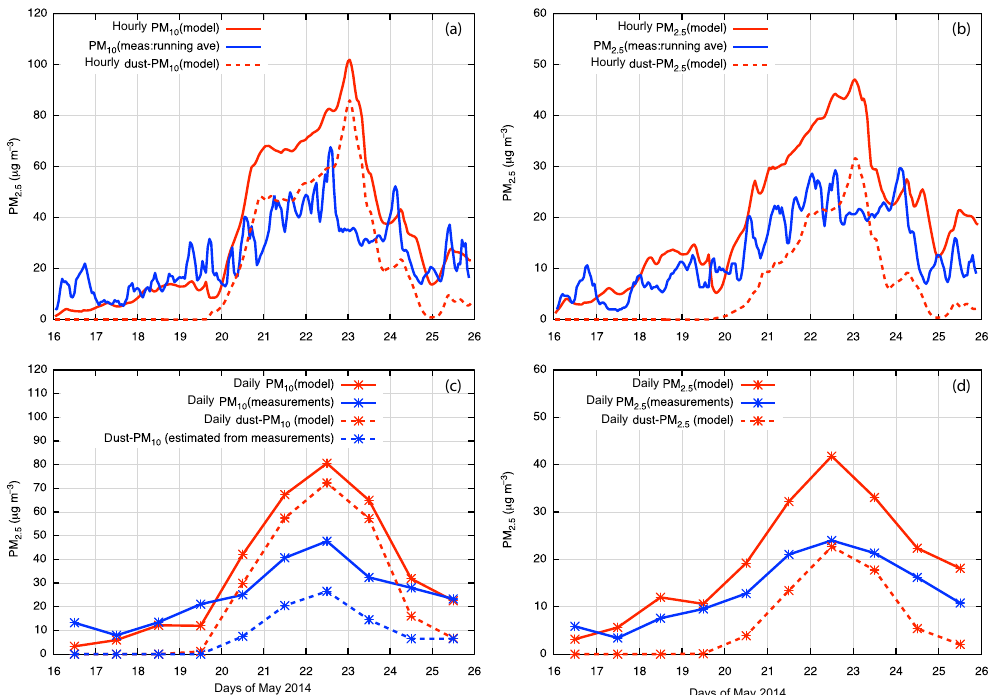
Figure 9. Temporal evolution of surface level PM 2 . 5 and PM 10 values and relevant desert dust contribution at Rome (Castel di Guido site) during the investigated period: (a) hourly resolved evolution of S01 modeled PM 10 (red continuous line), S01 modeled desert dust PM 10 (red dashed line), and PM 10 measurements (3h running average, blue continuous line); (b) as in (a) but for PM 2 . 5 ; (c) as in (a) but for daily-averaged data – in addition, daily desert dust PM 10 values obtained from measurements have been reported (dashed blue line) (see text for details); and (d) as in (b) but for daily-averaged